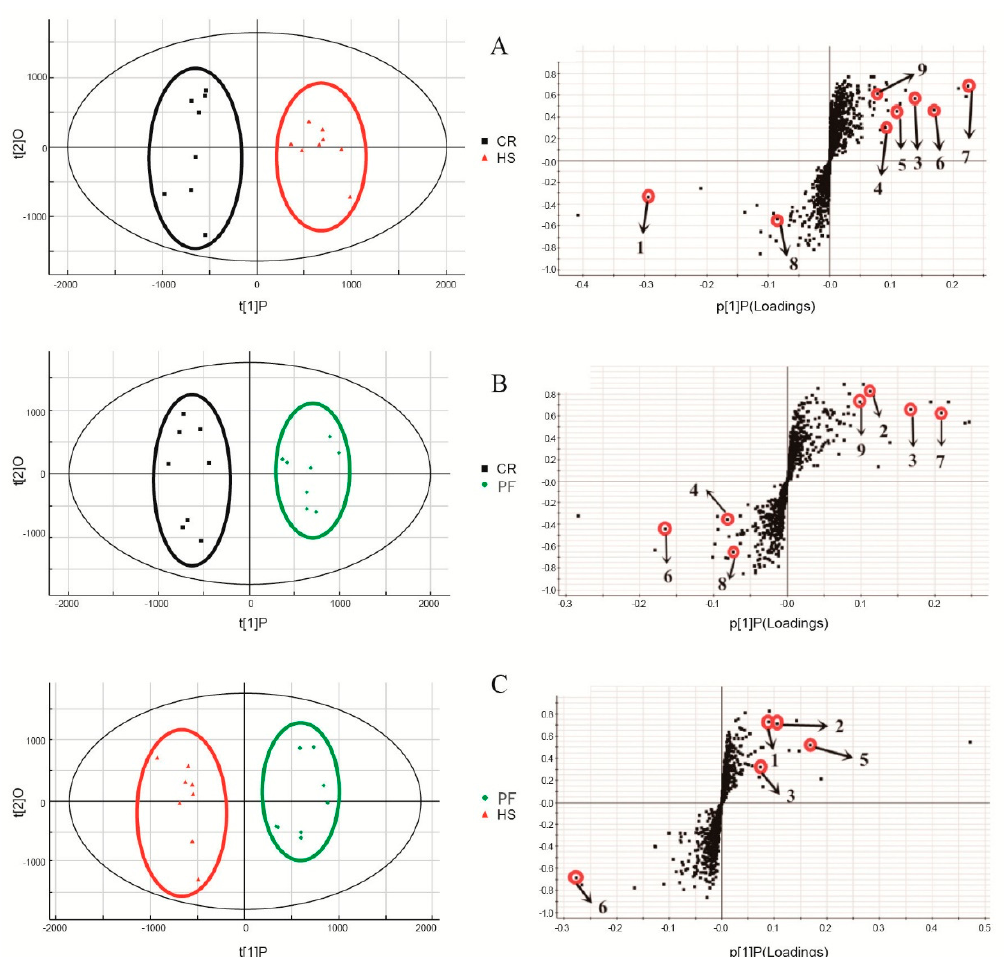
Figure 2. Identification of endogenous metabolites in muscle using UPLC-ESI-QTOF-MS-based metabonomics. The spots marked with different numbers represent different substances that are consistent with the Symbol ID in Table 1. ( A ) OPLS-DA score plots and OPLS S-plot based on muscle metabolites detected in CR and HS pigs in positive ion mode. ( B ) OPLS-DA score plots and OPLS S-plot based on muscle metabolites detected in CR and PF pigs in positive ion mode. ( C ) OPLS-DA score plots and OPLS S-plot based on muscle metabolites detected in HS and PF pigs in positive ion mode.